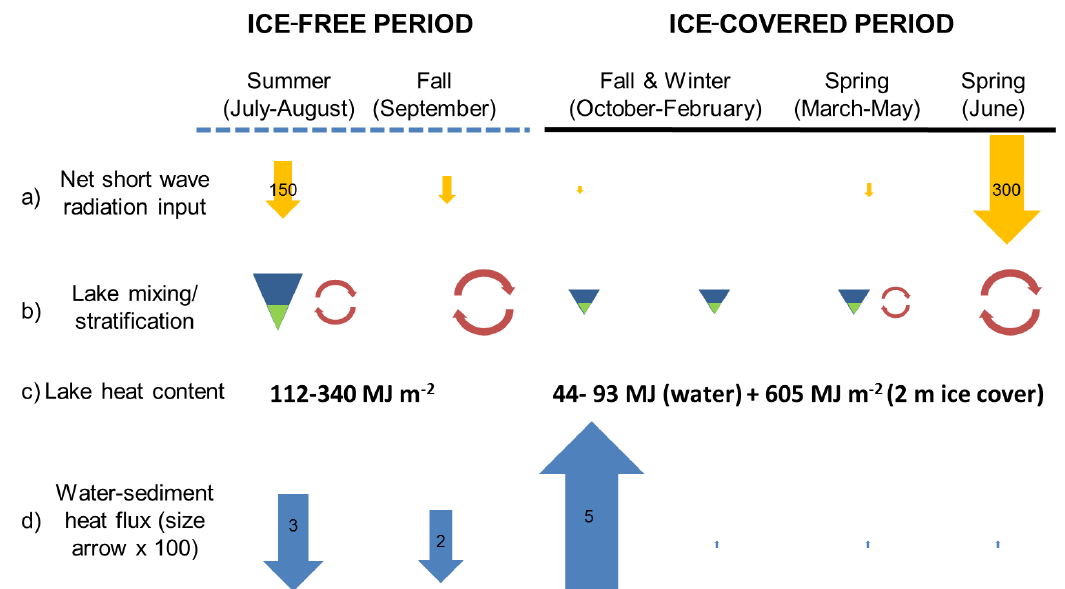
Figure 12. Summary of thermal processes in thermokarst lakes over a 1-year cycle. (a) Net short-wave radiation input (measured at the climate station on Samoylov); (b) dominant in-lake processes (mixing and stratification) – size of symbol reflects intensity of process; (c) lake heat content (divided into summer and winter lake heat content according to Wetzel, 2001); (d) average heat fluxes across the lake’s water-sediment boundary: downward arrows denote heat flux into the sediment and upward arrows flux out of the sediment into the water column. The size of the arrows and their numbers indicate the relative magnitudes of the fluxes [Wm − 2 ]. Note that the sizes of arrows representing bottom heat fluxes have been enlarged by a factor of 100 due the small magnitude of the